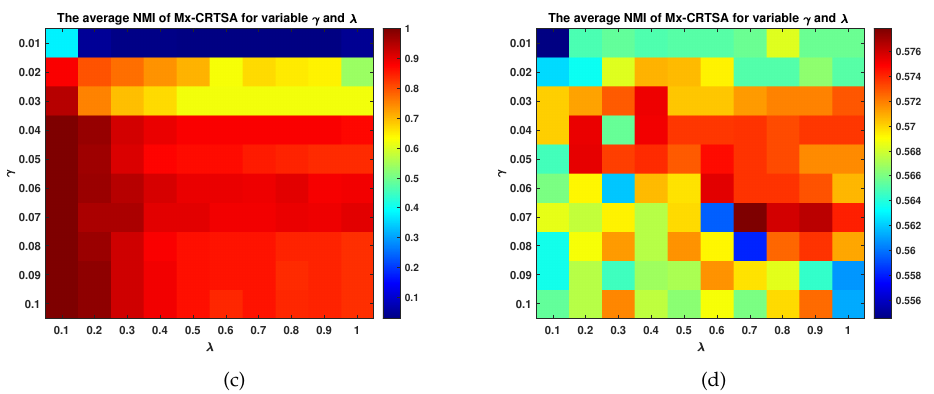
Figure 7. Sensitivity of the proposed Mx-CRTSA in terms of NMI to the regularization parameters in ( a ) Cora, ( b ) C. Elegans, ( c ) CKM and ( d ) Wikipedia networks.